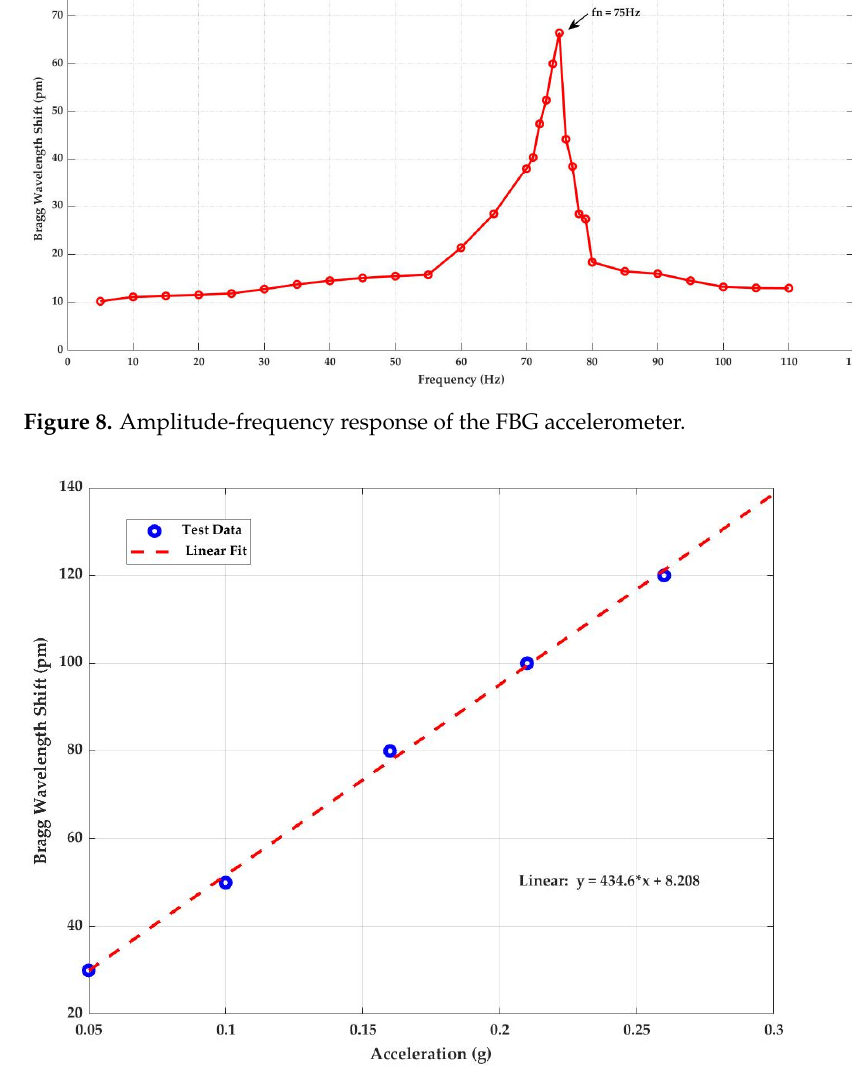
Figure 9. Linear response of Bragg wavelength shift versus applied acceleration at frequency 20 Hz.